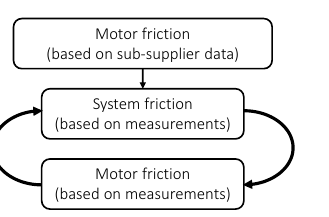
Figure 9: Iterative optimization loop of friction param- eters.